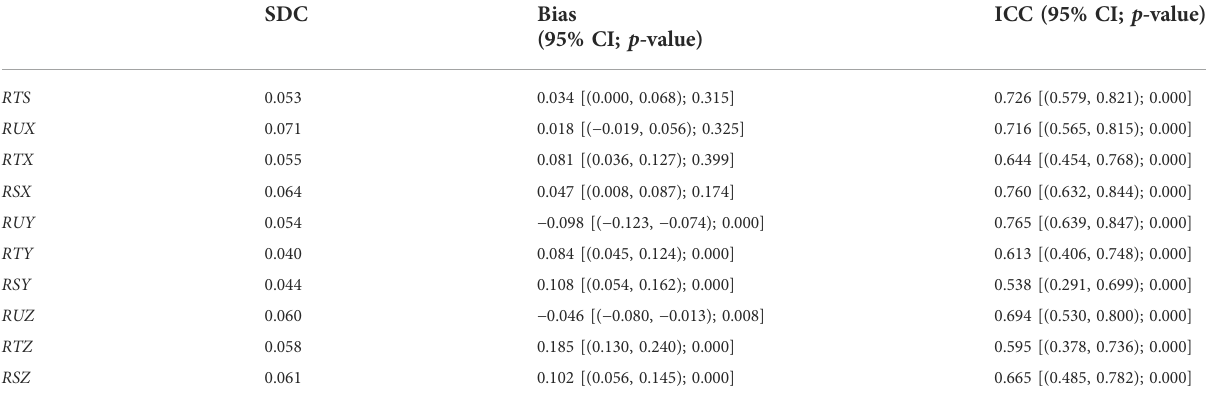
TABLE 3 Comparison of characteristics between marker and markerless motion